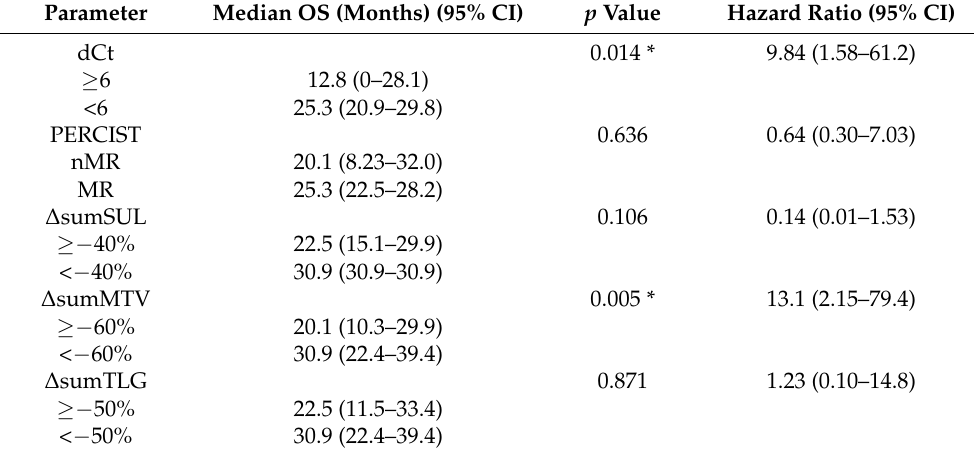
Table 4. Multivariate analysis of parameters and association with OS ( n =